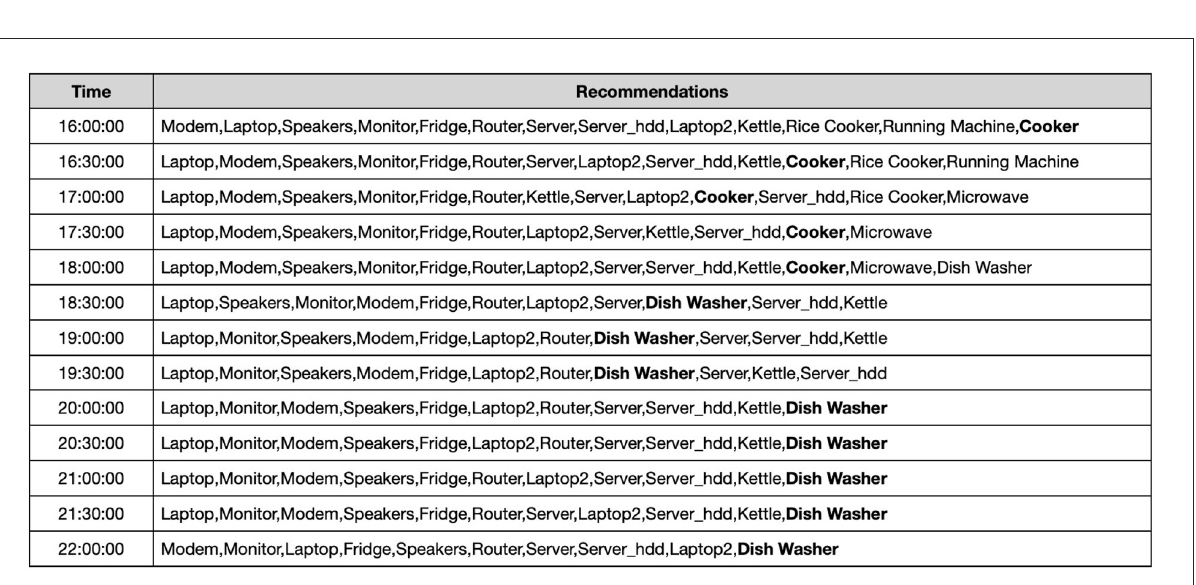
Figure 5. These itemsets have been used to generate rules and recommendations for House